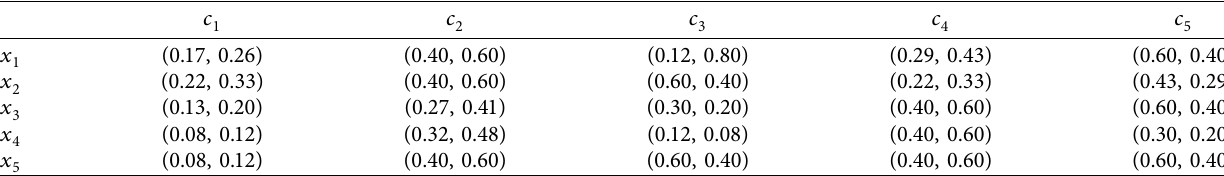
Table 3: Normalized rating.